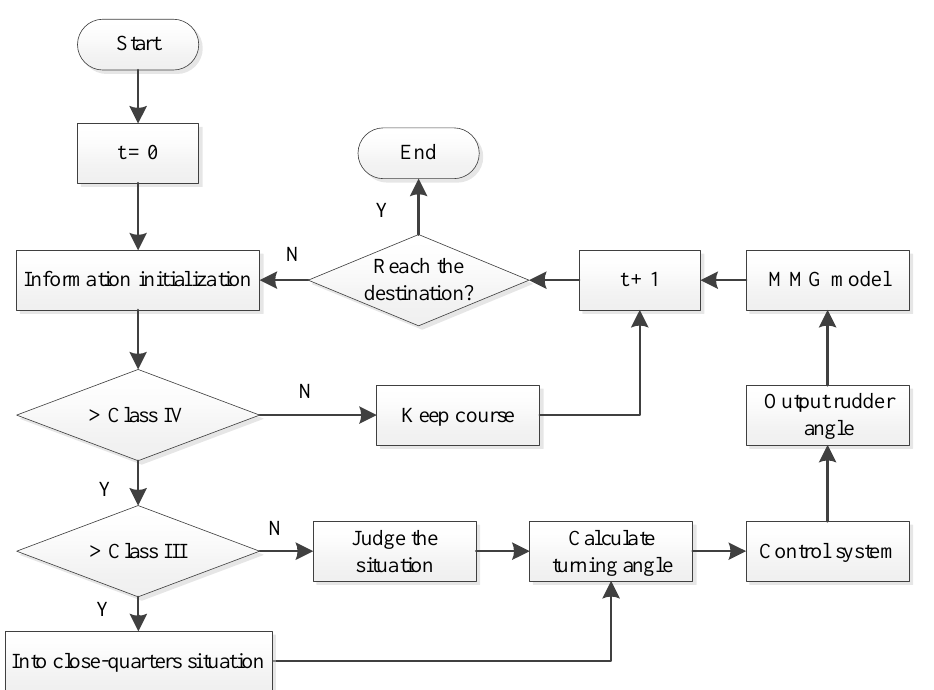
Figure 13. Flow chart the of collision-avoidance decision system.